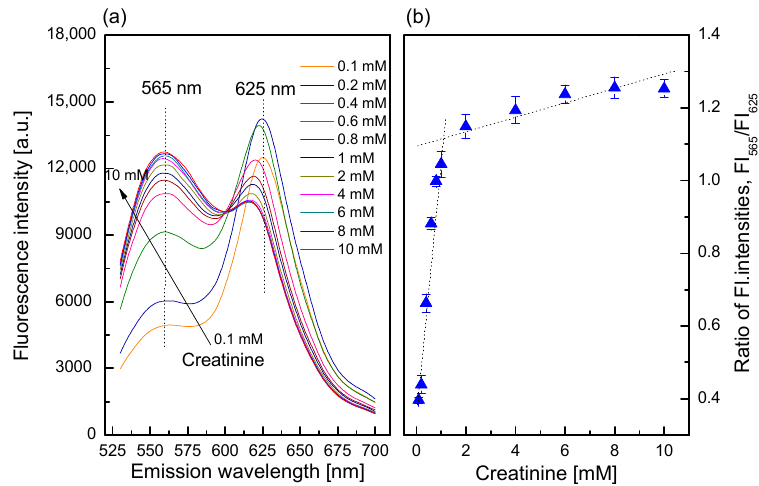
Figure 7. ( a ) Fluorescence emission spectra of the creatinine-sensing membrane in the presence of creatinine at 0.1 to 10 mM concentration monitored at an excitation wavelength of 460 nm. ( b ) Calibration curve for creatinine calculated by the ratio of two fluorescence intensities at emission wavelengths of 565 and 625 nm.